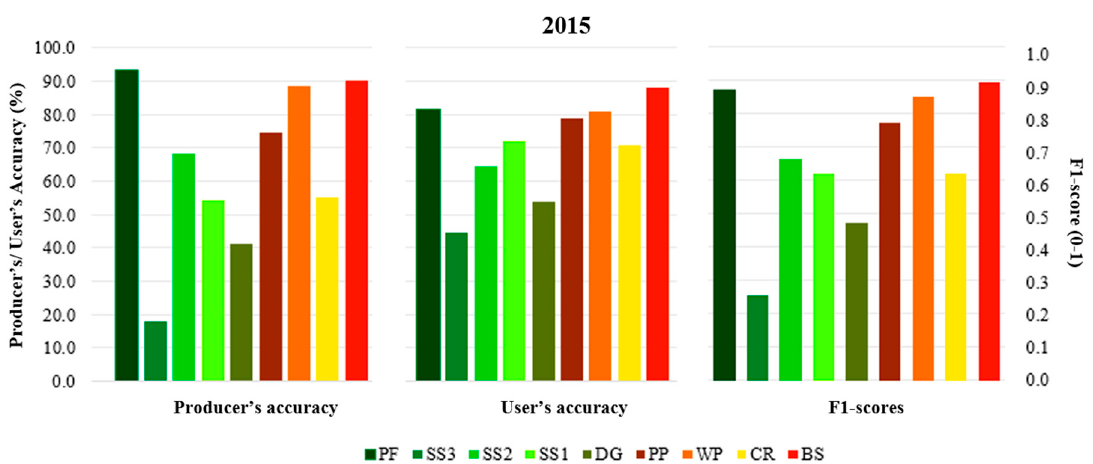
Figure 8. Producer’s accuracy, user’s accuracy, and F1-scores of Yamaguchi classification for 2015, based on the RF algorithm. For LULC class identification, see Table 1.